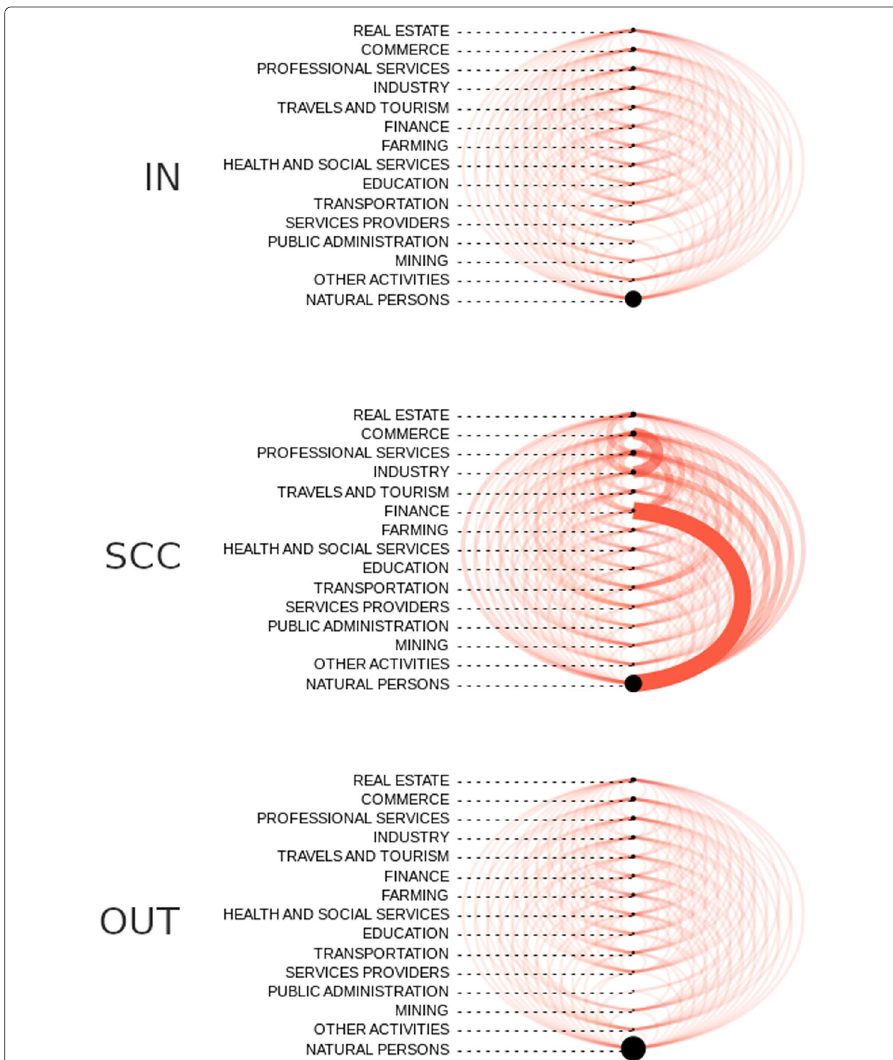
Fig. 15 Wire transfer within components: Total amount of wire transfers between nodes in the three components (IN, SCC and OUT). Legal persons are classified by their business sectors. The size of the points representing the sectors is proportional to the number of the nodes in each component referring to a given category. Directions of payments are clock-wise